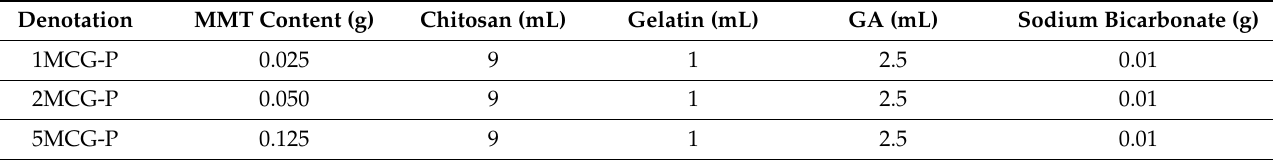
Table 2. Denotation and specification of CS/Gel/MMT/PCL bone